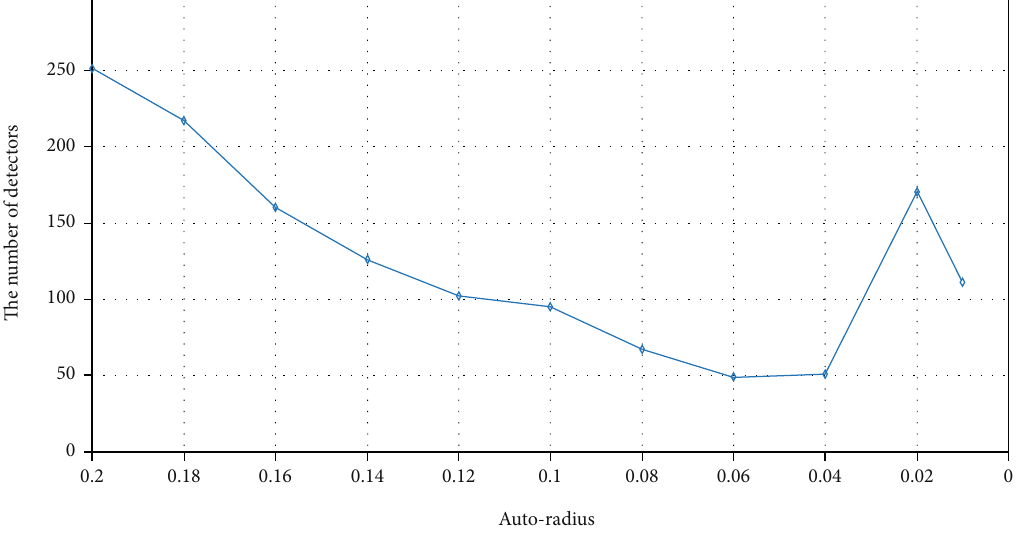
Figure 5: E ff ect of self-space auto-radius on the number of detectors.